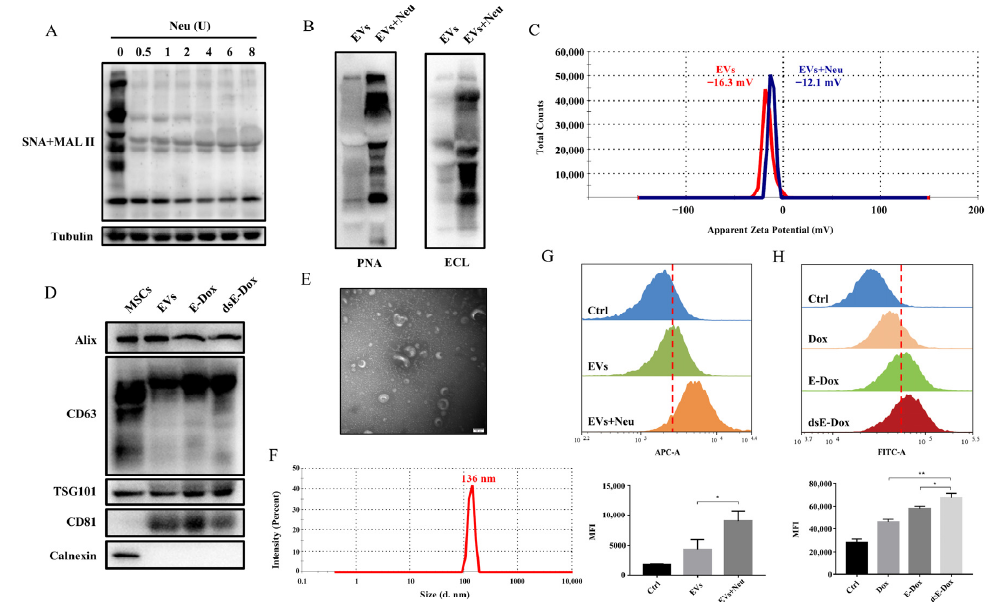
Figure 3. The effect of desialylation on the cellular uptake of MSC-EVs. ( A ) MSC-EVs were treated with different concentrations of neuraminidase for 30 min at 37 °C. The sialic acid level was deter- mined by lectin blotting. ( B ) The Gal and GalNAc levels of EVs were detected by lectin blotting with 4 U neuraminidase treatment at 37 °C for 30 min. ( C ) The zeta potential of EVs treated with or without neuraminidase was estimated by DLS. ( D ) Positive markers, Alix, CD63, TSG101, and CD81, and negative marker calnexin of the MSC-EVs, E-Dox and dsE-Dox were analyzed by Western blotting. ( E , F ) The morphology and size of the desialylated MSC-EVs were detected by TEM and DLS, respectively. Scale bar, 100 nm. ( G ) MSC-EVs and desialylated MSC-EVs were labeled with ExoTracker, and their cellular uptake were analyzed by flow cytometry. ( H ) Uptake of free Dox, E-Dox, and dsE-Dox (loaded with 2 µ mol/L Dox) were analyzed by measuring the autofluorescence of Dox using flow cytometry. The data were presented as the mean values ± SD. * p < 0.05, ** p <